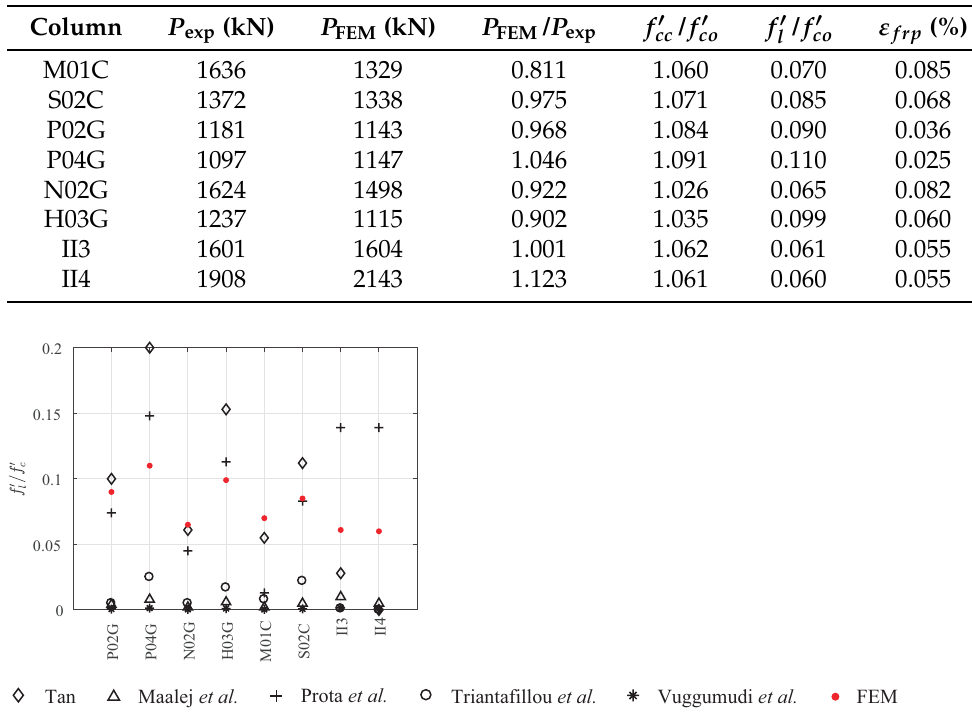
/ f (cid:48) co : comparison between FEM and analytical l